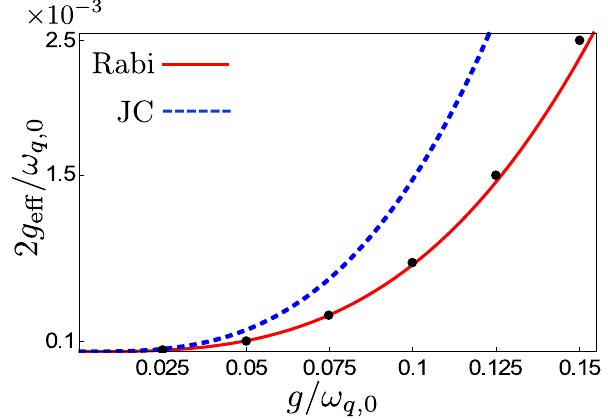
Figure 10. Comparison of analytical (JC Hamiltonian [dashed blue curve] and quantum Rabi Hamiltonian [solid red curve]) and numerical (black dots) results for the effective coupling between the states |1, 0, e 〉 and |0, 2, g 〉 . The graph shows the minimum energy splitting 2 g eff / ω q ,0 as a function of g / ω q ,0 , using the same parameters as in Fig.